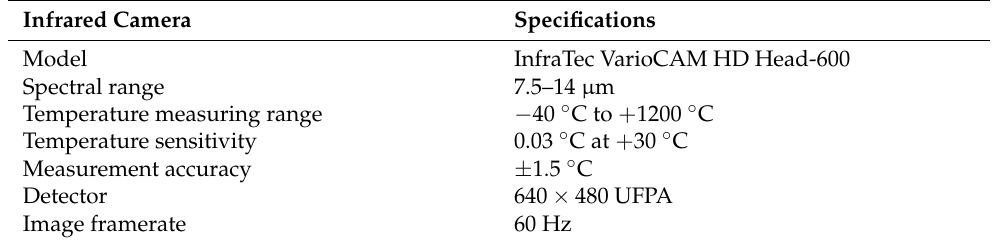
Table 3. Technical specifications of the thermographic camera used in this